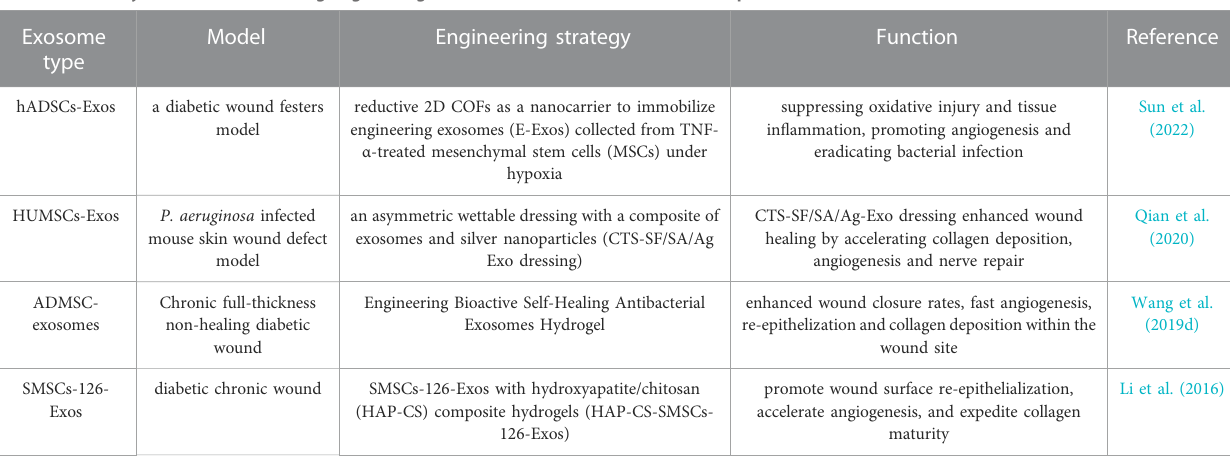
TABLE 3 Summary of research concerning engineering exosomes-loaded scaffold in wound